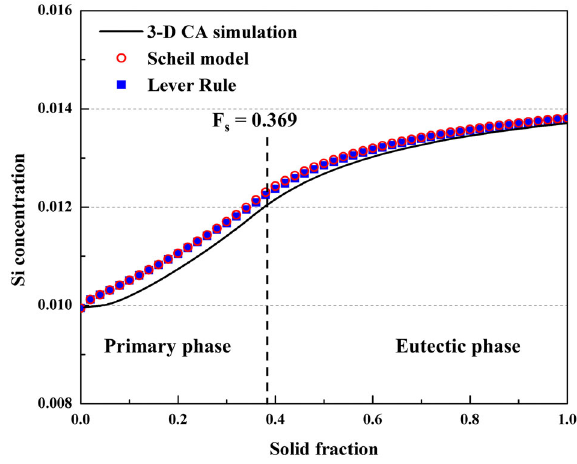
Fig. 8 Model validation. Comparison of the simulated Si concen- trations in the α -Al phase vs. the solid fraction by the 3-D CA simulation, Scheil model, and lever rule.